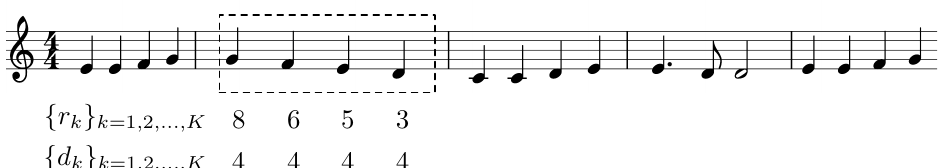
Figure 3. The note-based representation for symbolic melody. r k contains the pitch class information of the k -th note in the dashed rectangle, while d k represents the duration value of the k -th note.